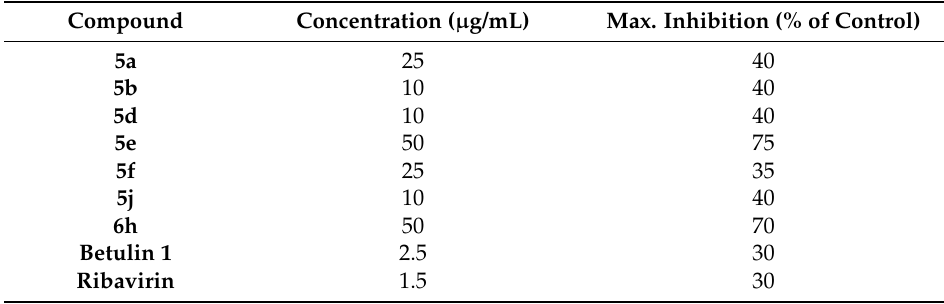
Table 3. Antiproliferative activity of triazoles in the SKOV-3 human ovarian cancer line in comparison to betulin 1 and